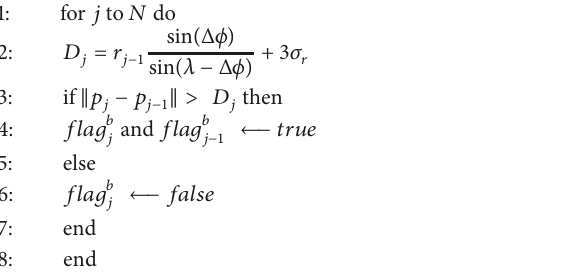
Table 1: Pseudocode of the Adaptive Breakpoint Detector algo-